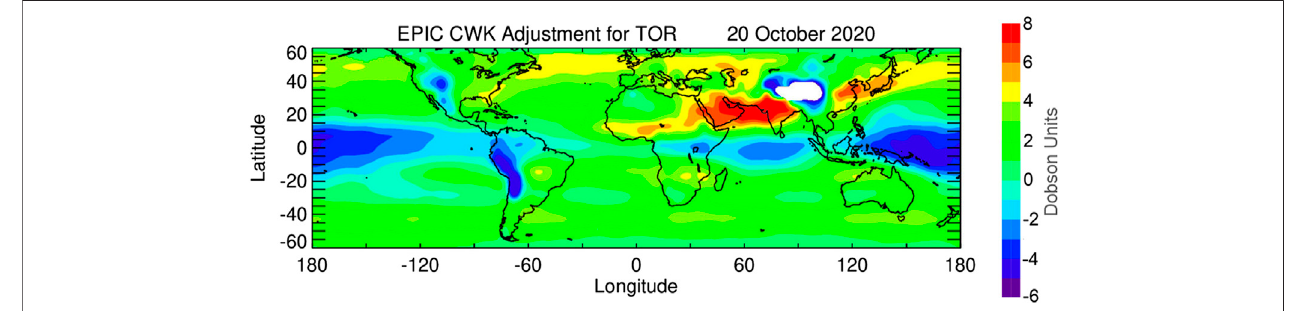
FIGURE 5 | Spatial map of the CWF adjustment for the EPIC TCO due to reduced EPIC sensitivity to BL ozone for 20 October 2021. This correction is derived by applying EPIC CWFs for the bottom layer (506 hPa-1000 hPa) to the differences between GEOS-Replay model and ML apriori ozone.